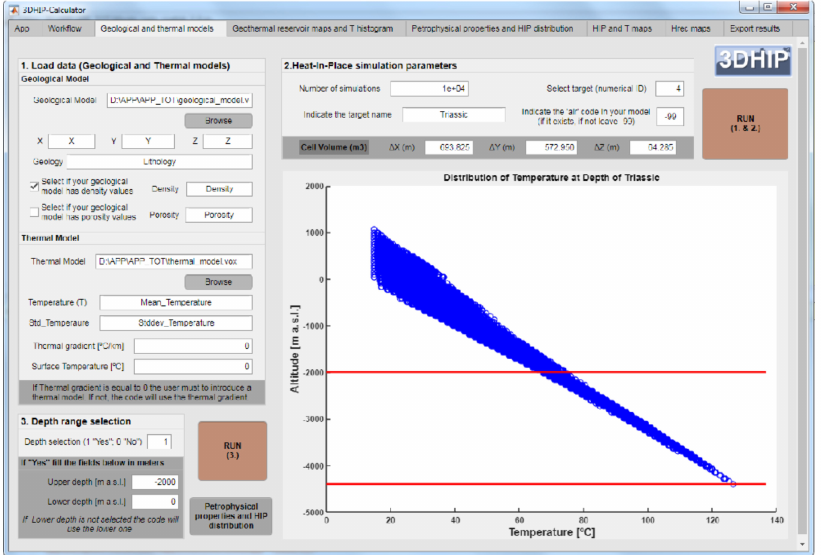
Figure 8. Altitude with respect to the temperature distribution for the selected target in example 3 (Triassic unit). Each blue circle corresponds to a voxel temperature value within the target reservoir. The red lines indicate the depth range fixed for performing calculations.